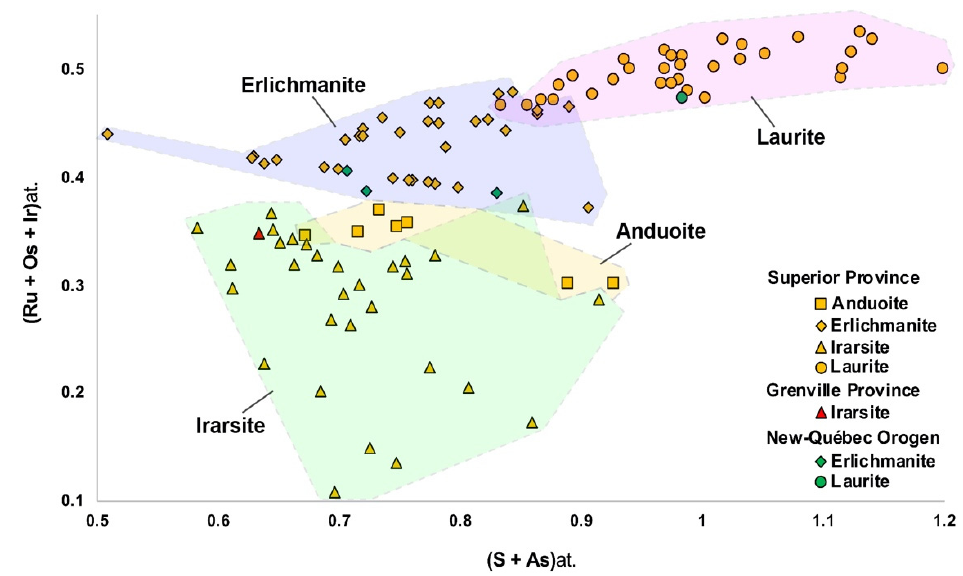
Figure 19. Covariation of (Pt at. + Pd at. + Rh at.) vs. (As at. + S at.) in the composition of relatively abundant platinum-group minerals (PGMs) including sperrylite, braggite, cooperite, isomertieite, mertieite-I, and mertieite-II recovered from till collected from different geological settings within the Canadian Shield. The elemental values are presented in atomic proportions (at.). Although regional differences are noted, most of these minerals show ubiquitous distributions.